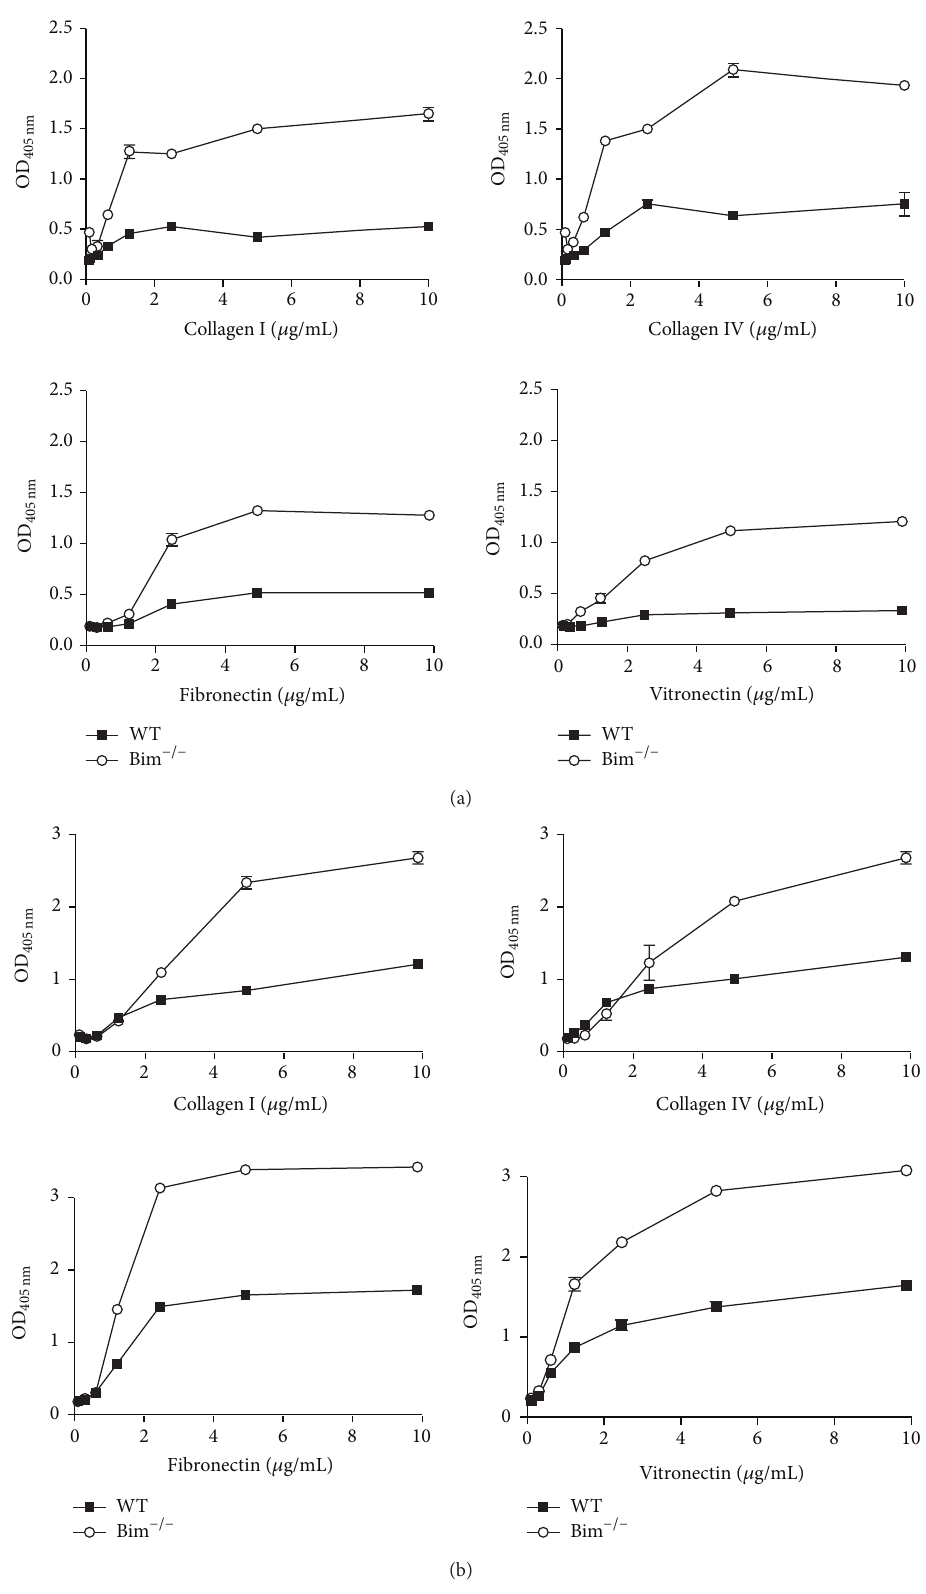
Figure 4: Bim −/− endothelial cells and pericytes were more adherent. The adhesion of retinal wild-type ( ◼ ) and Bim −/− ( I ) endothelial cells (panel (a)) and pericytes (panel (b)) to fibronectin, vitronectin, collagen type I, or collagen IV was determined as described in Section